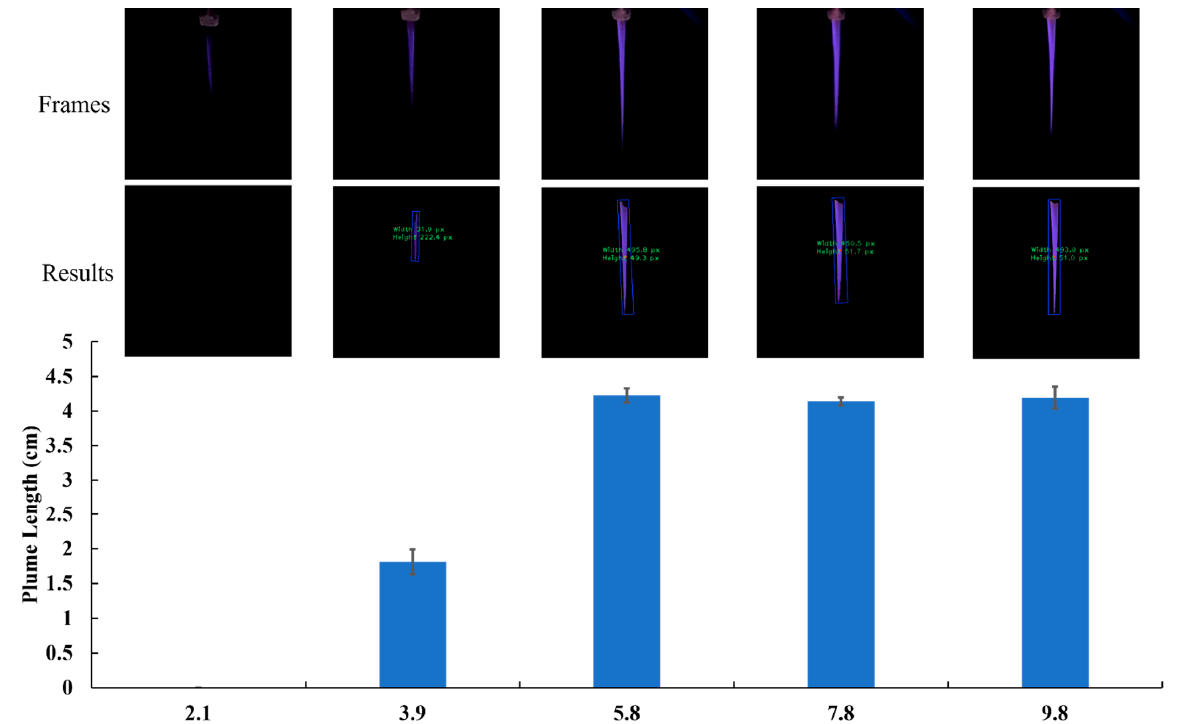
Figure 5. Electrodes’ gap affects plasma plume’s length. Electrodes’ gap was varied from 2.1 cm to 9.8 cm, while discharge frequency, duty cycle, and gas flow were held constant at 16 kHz, 25%, and 4.2 lpm, respectively. These photos are images of the live video stream fed into the program (top row: frames) and the output after selecting only the plasma regions (bottom row: results). All experiments were repeated three times. The results were shown as the mean ± standard deviation (error bar).